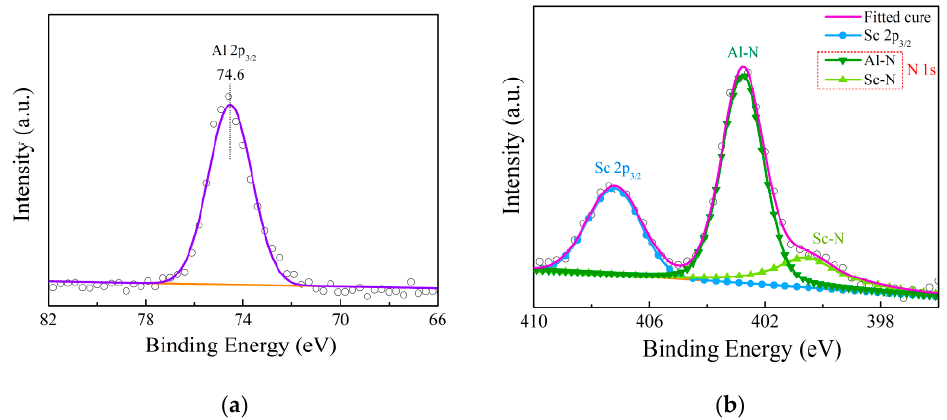
Figure 4. XPS elemental spectra for Sc 0.29 Al 0.71 N thin film: ( a ) Al 2p 3/2 ; ( b ) N 1s and Sc 2p 3/2 .